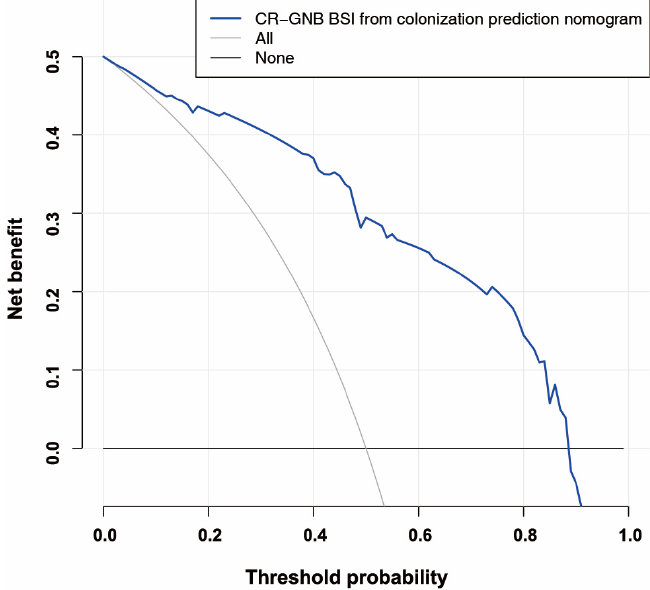
Figure 5. An assessment of the calibration curves for secondary CR-GNB BSI risk nomogram pre- diction. The x-axis shows the predicted risk of secondary CR-GNB BSI. The y-axis shows the actual secondary CR-GNB BSIs that have been diagnosed. The diagonal dotted line in the diagram repre- sents the prediction of the ideal model. The solid line represents nomogram performance, with a closer fit to the diagonal dotted line representing a better prediction. Abbreviations: CR-GNB (car- bapenem-resistant Gram-negative bacteria); BSI (blood stream infection).